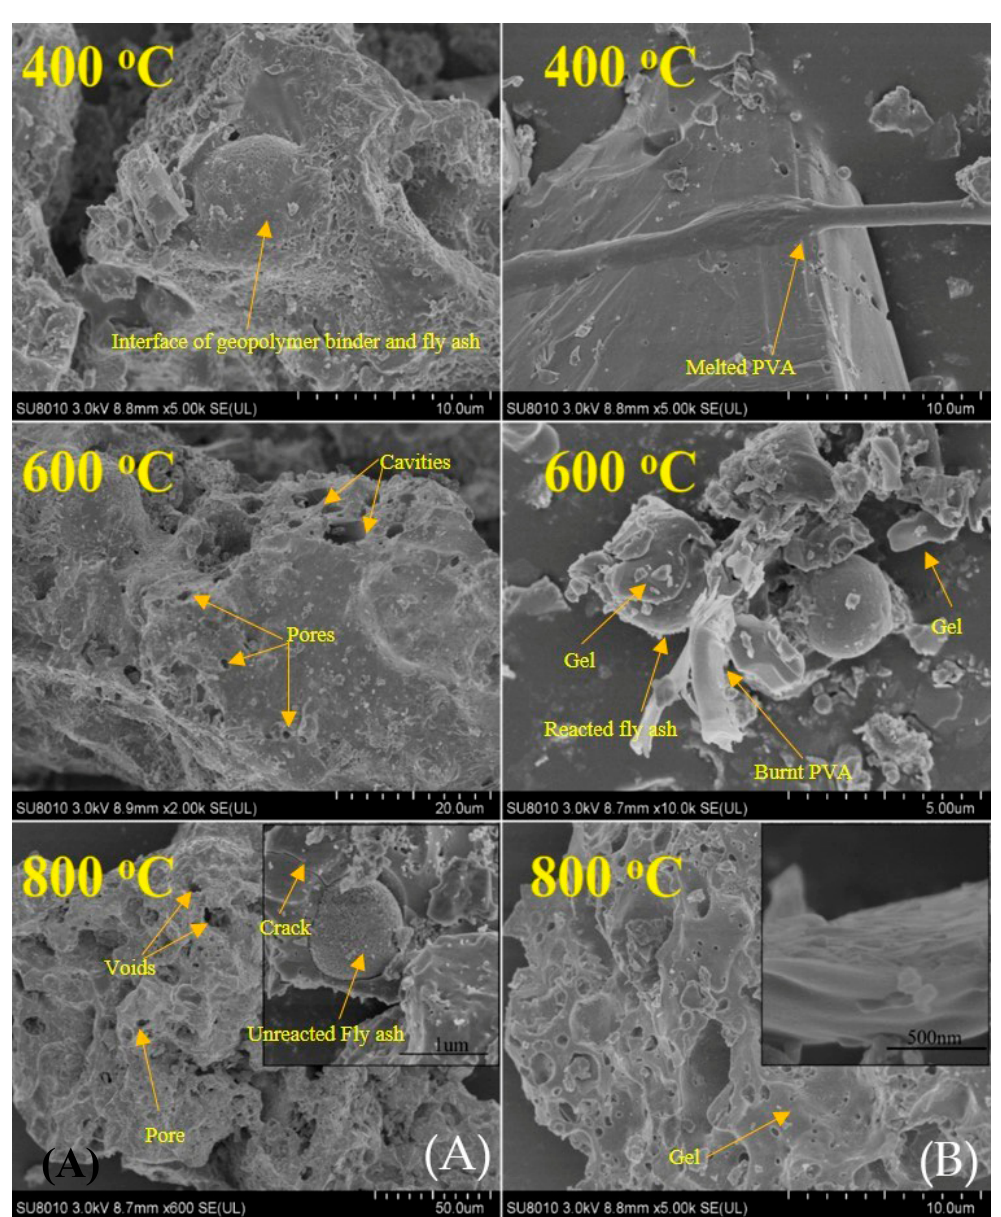
Figure 15. FESEM images of geopolymers at different temperatures: ( A ) Without PVA fibers (left); ( B ) with PVA fibers (right).